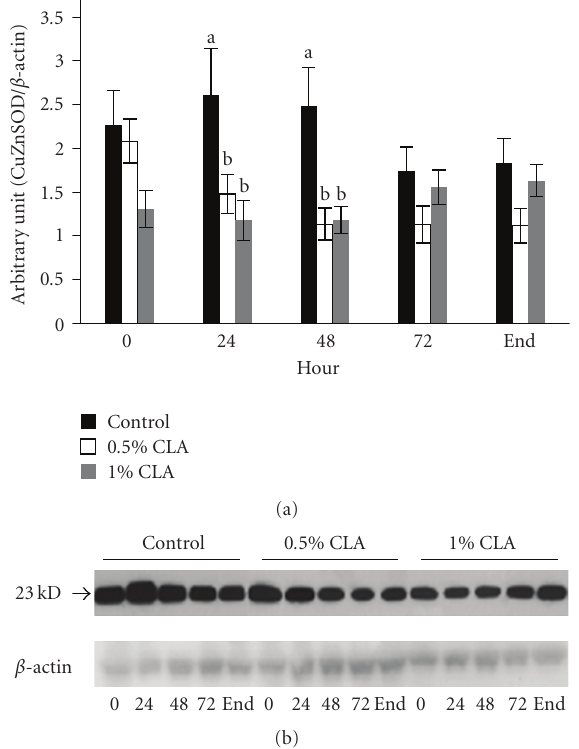
Figure 8: MnSOD protein expression in cutaneous wounds of mice fed diets containing 0 (control), 0.5%, or 1% CLA for 2 weeks. (a) Quantified MnSOD protein expression level determined by densitometry. Values are mean ± SEM; N = 4 to 6 in each group. Means at a time with a di ff erent letter are significantly di ff erent, P < . 05. (b) 0; 0hr, 24; 24 hr, 48; 48 hr, 72; 72 hr after wounding, end (wound is completely